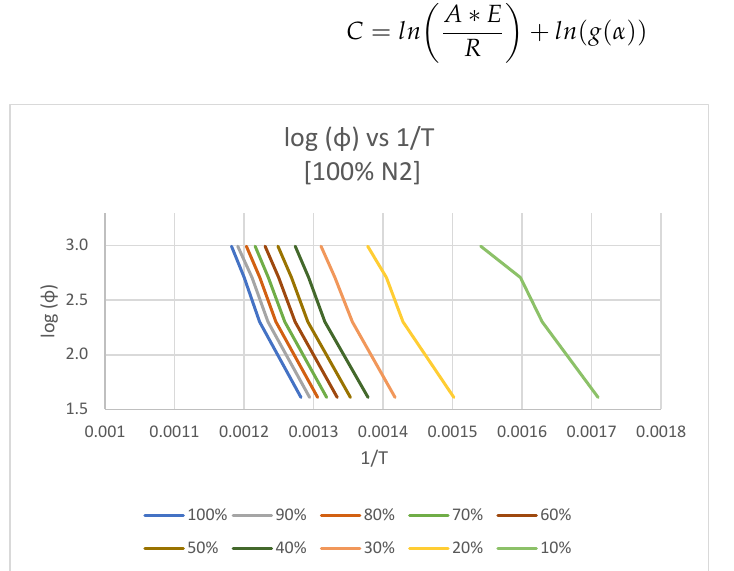
Figure 5. Ozawa’s method for thermal decomposition, fixed for each percentage of mass loss [own elaboration]. Table 2. Apparent activation energy during thermal decomposition.